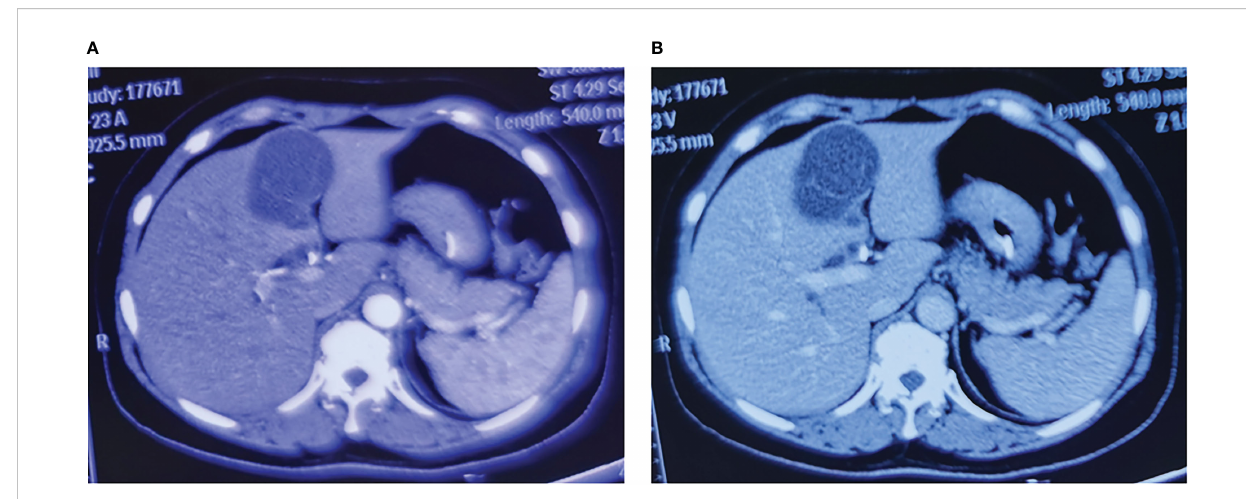
FIGURE 1 Typical images of contrast-enhanced computed tomography of the liver lesions. (A) The arterial phase image of the liver lesions. (B) The venous phase image of the liver